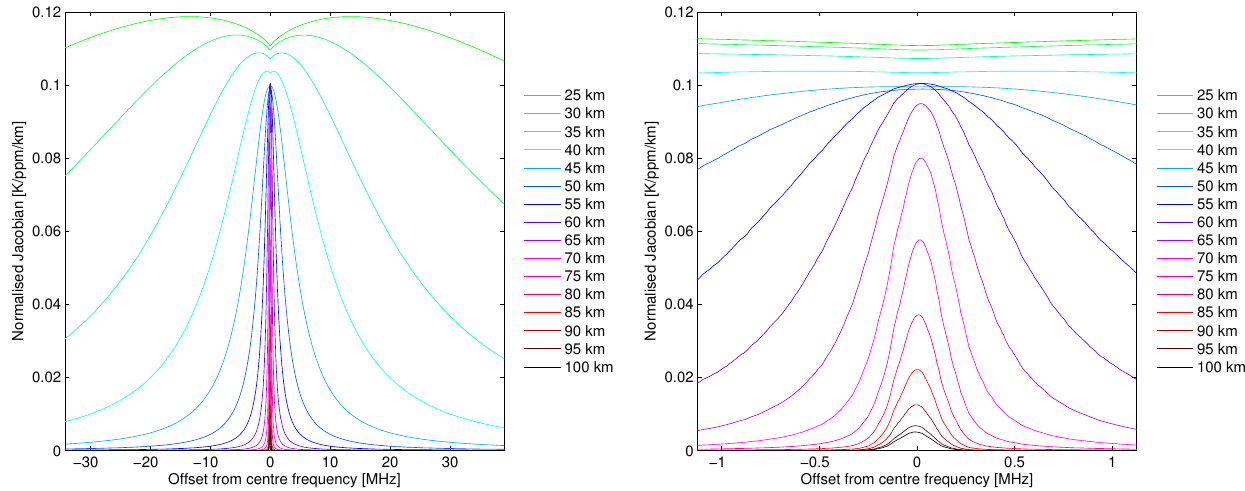
Figure 4. Rows of the Jacobian describing WIRA’s ozone retrieval normalised by the layer thickness of the retrieval grid for observations at 22 ◦ elevation. Full usable spectrometer bandwidth (left) and zoom on the central channels